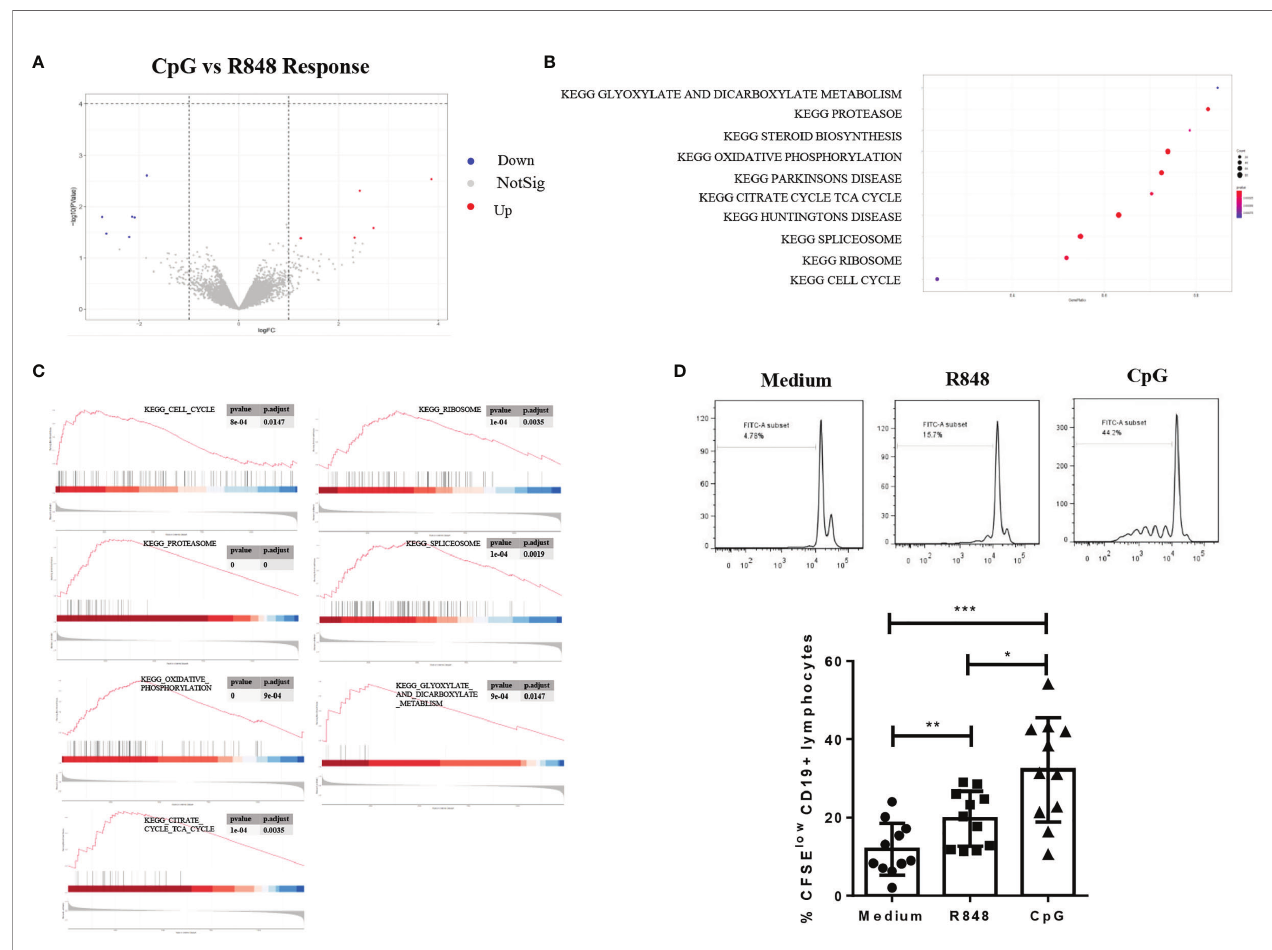
FIGURE 4 | Comparison of transcriptional regulatory networks after TLRs activation in B cells. Volcano plot showing 13 differentially expressed genes (DEGs) in B cells upon CpG versus R848 stimulation (A) . GSEA analysis was performed on the CpG- versus R848-stimulated B cells, and the top 10 gene sets are shown (B) . GSEA analysis on the KEGG pathway of “ Cell cycle ” , “ Ribosome ” , “ TCA cycle ” , “ Spliceosome ” , “ Oxidative phosphorylation ” , “ Glyoxylate and dicarboxylate metabolism and proteasome ” and “ TCA cycle ” are shown (C) . The proliferation of CD19 + B cells after R848 and CpG stimulation was determined by fl ow cytometry using CFSE. The results were expressed as the mean percentage of proliferative CD19 + B cells ± SD, and each symbol represents an individual subject (n = 11) (D) . Statistical analysis was performed by one-way ANOVA, and *P < 0.05, **P < 0.01, and ***P <